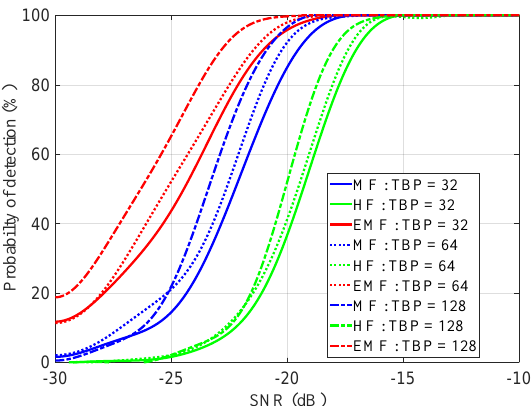
Figure 13. Receiver operational characteristic (ROC) for MF, HF, and the proposed